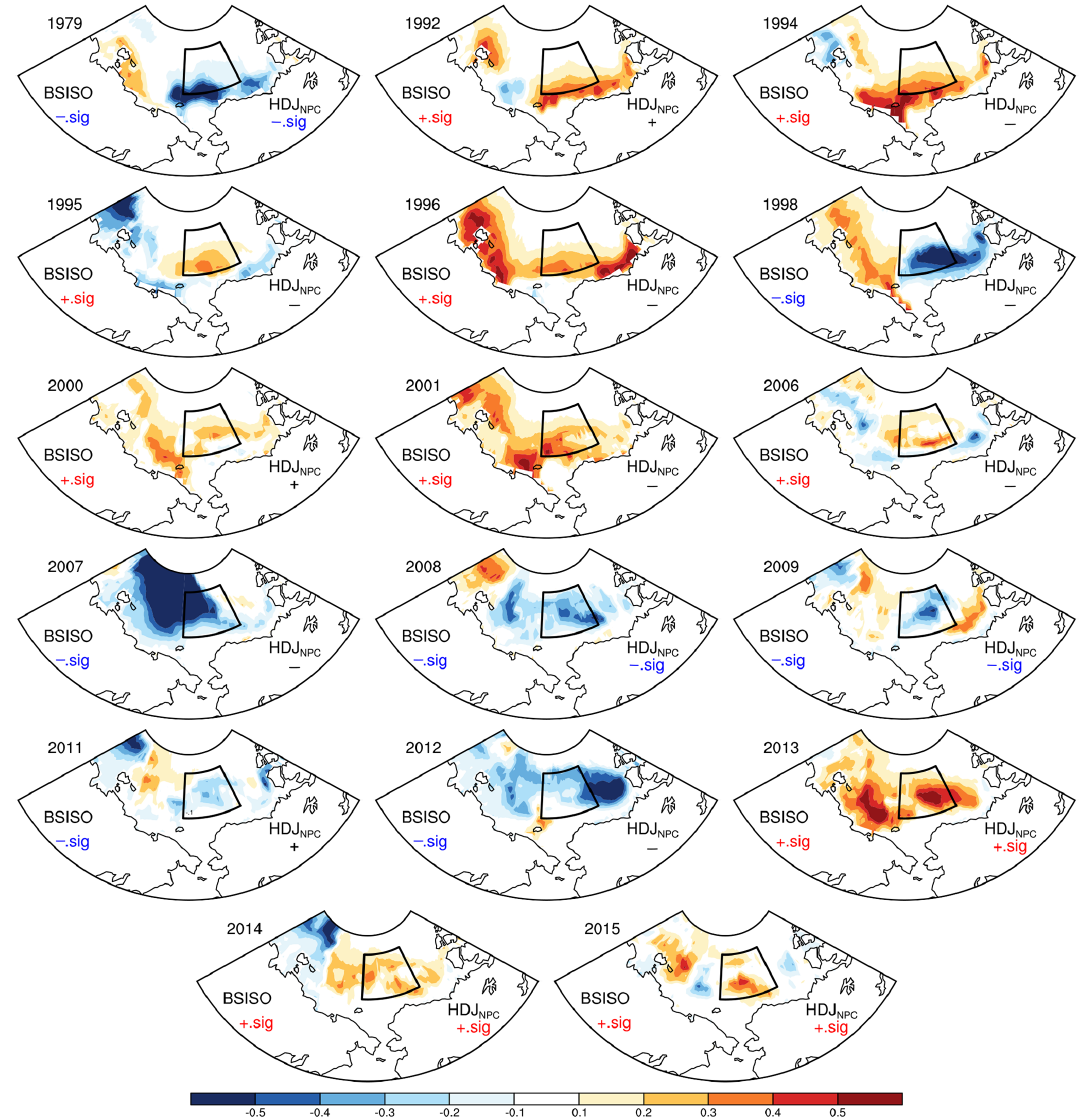
Figure 4. Distributions of the September–October sea ice concentration after removal of the linear trend in typical years (i.e., the year when | BSISO | >0 . 8 × its standard deviation). The “ + ” and “ − ” represent the mathematical sign of the BSISO and HDJ indicates that the absolute value of the index anomaly was larger than 0 . 8 × its standard